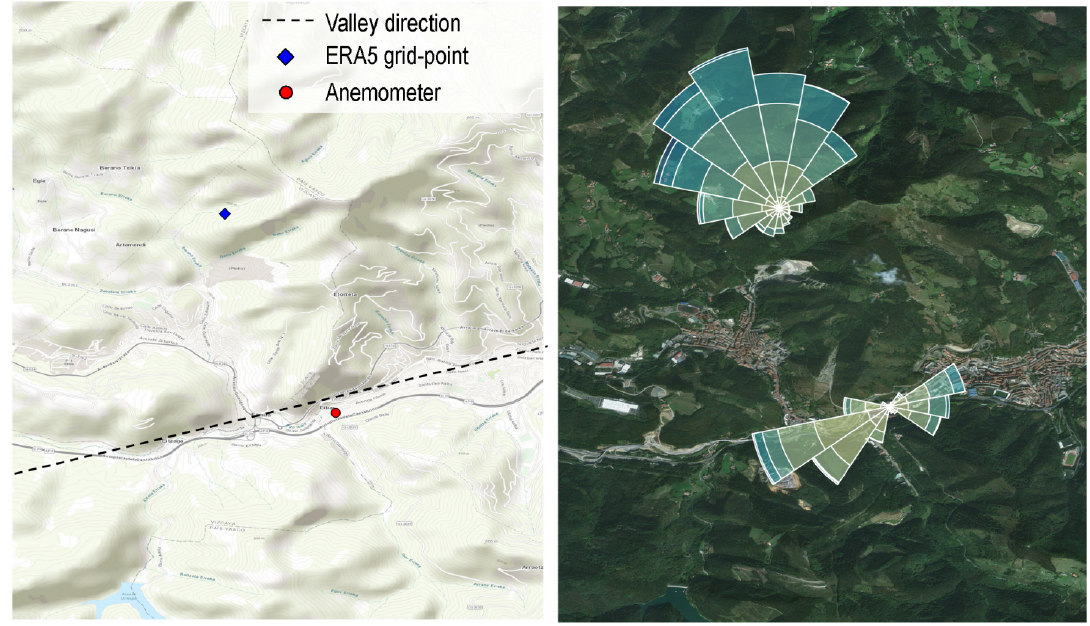
Figure 11. Details of the location of the anemometer and the nearest ERA5 grid point ( left ). Representation of the corresponding wind roses of ERA5 and anemometer data ( right